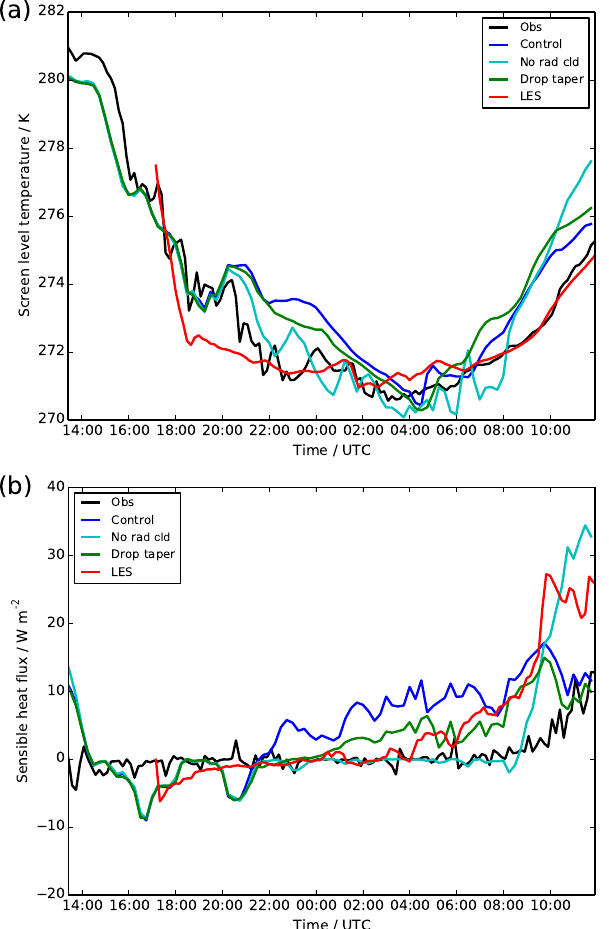
Figure 2. Time series of observations (black), LES (red) and UKV experiments: control (blue), radiatively inactive cloud (cyan) and modified droplet number (green), showing (a) screen (1.5m) tem- perature and (b) surface sensible heat flux.